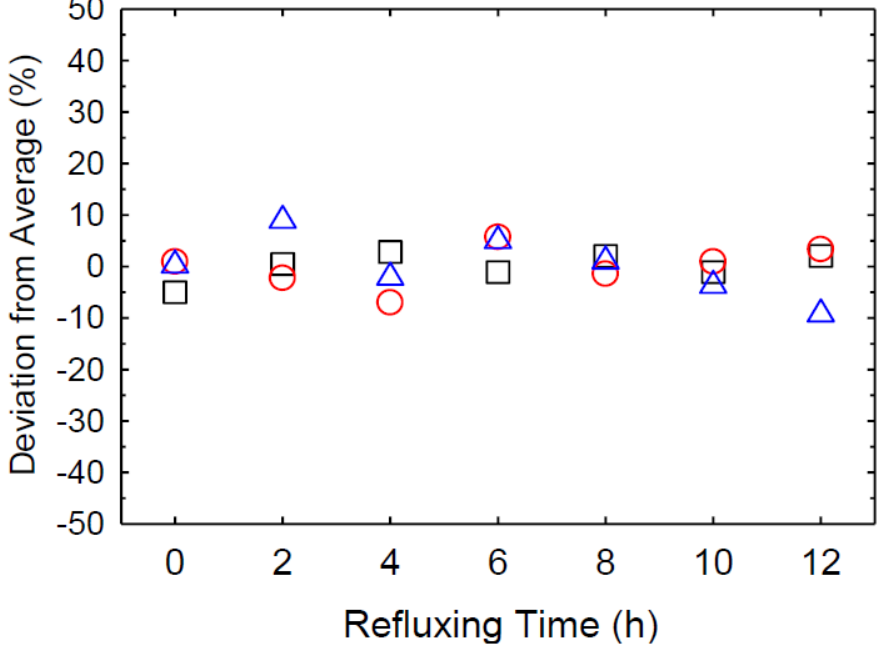
Figure 8. Evaluation on the sample stability based on the percentage deviation of observed fluores- cence quantum yields from the average value after the dot sample was refluxed in THF (66 ◦ C, circle), toluene (111 ◦ C, square), and chlorobenzene (132 ◦ C, triangle) for up to 12 h.